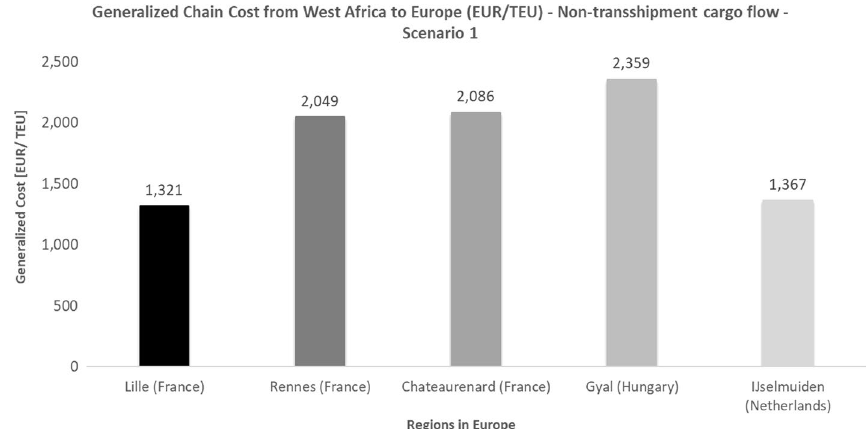
Fig. 7 Generalized chain cost for European regions in scenario 1